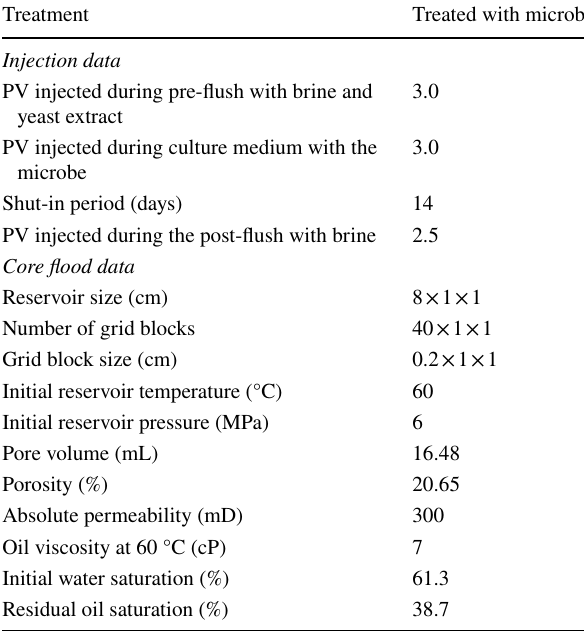
Fig. 2 Schematic diagram for relative permeability changes highlighting three stages of adsorption: suspension of microbes right after injection, reversible adsorption stage at the onset of microbe growth and irreversible adsorption and microbe colonization stage Table 3 Simulation input